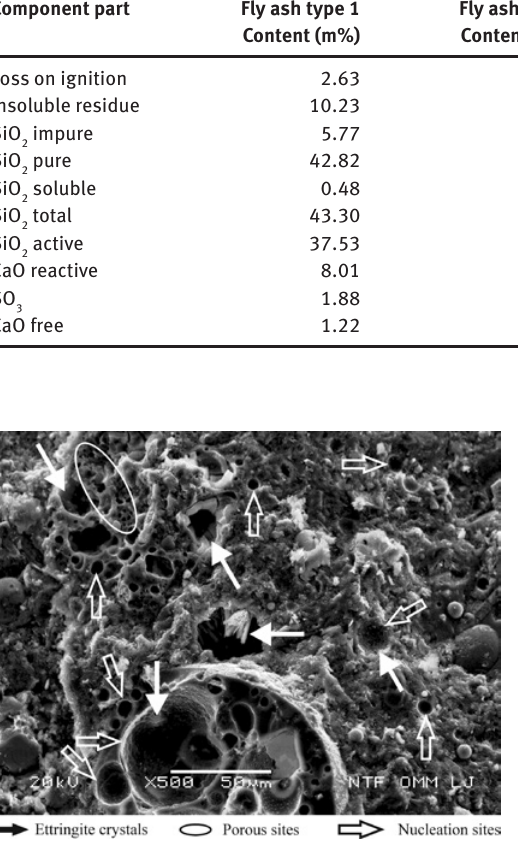
Figure 2 Micro fractography of the sample AI with ettringite crystals; scanning electron microscope (SEM), secondary electron imaging (SEI).